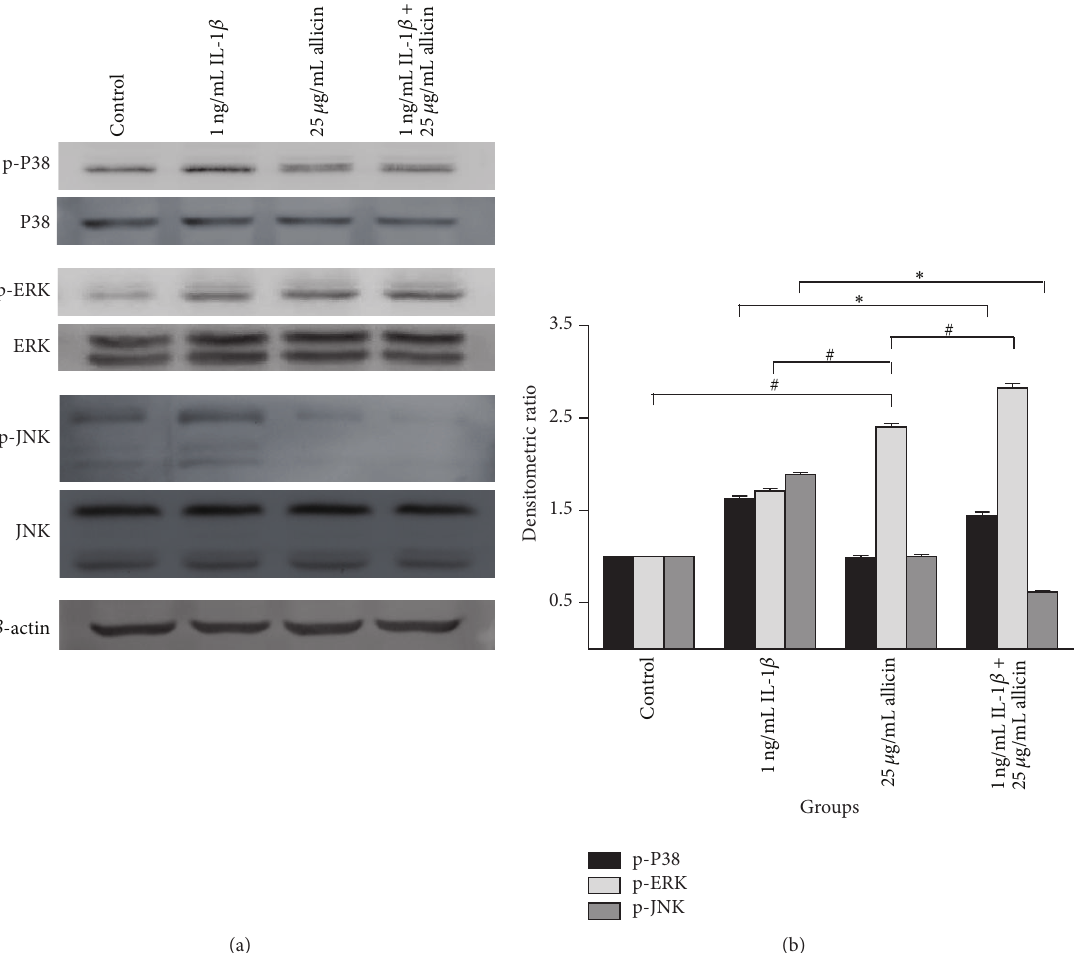
Figure 7: The change of P38, ERK, and JNK of allicin on IL-1 𝛽 -induced Caco-2 cells. Results were repeated 3 times and presented by SDS- PAGE (a) and densitometric analysis (b). 25 𝜇 g/mL allicin attenuated IL-1 𝛽 -induced phosphorylations P38 and JNK pathways. Both 1ng/mL IL-1 𝛽 and 25 𝜇 g/mL activated ERK pathway. ∗ 𝑃 < 0.05 1ng/mL IL-1 𝛽 + 25 𝜇 g/mL allicin versus 1ng/mL (IL-1 𝛽 p-P38 and p-JNK). # 𝑃 < 0.05 versus 25 𝜇 g/mL allicin